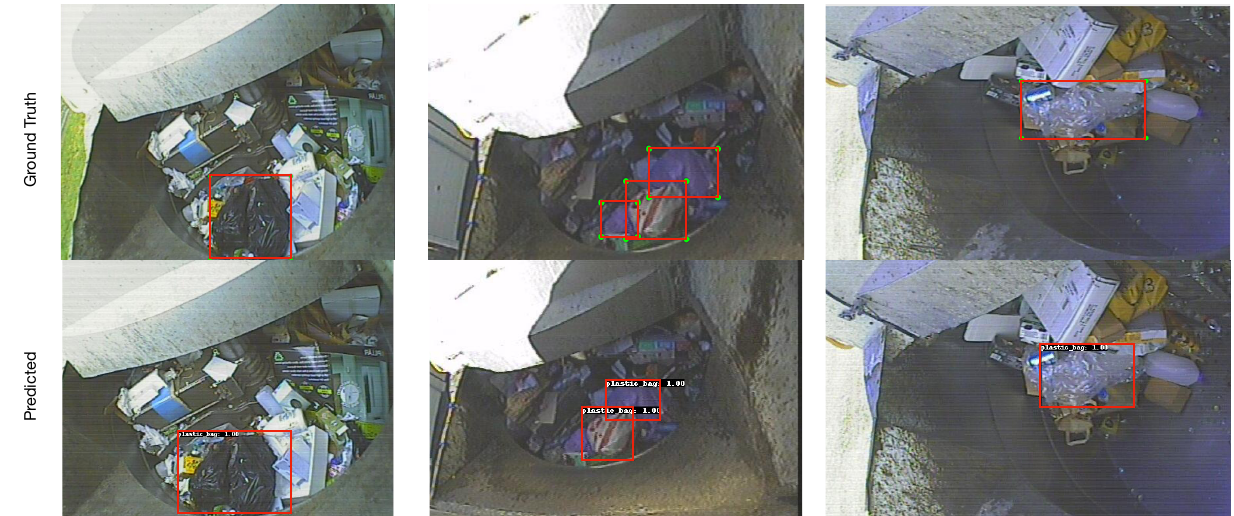
Figure 12. Sample correct predictions by the YOLOv4 with CSPDarkNet_tiny backbone model.